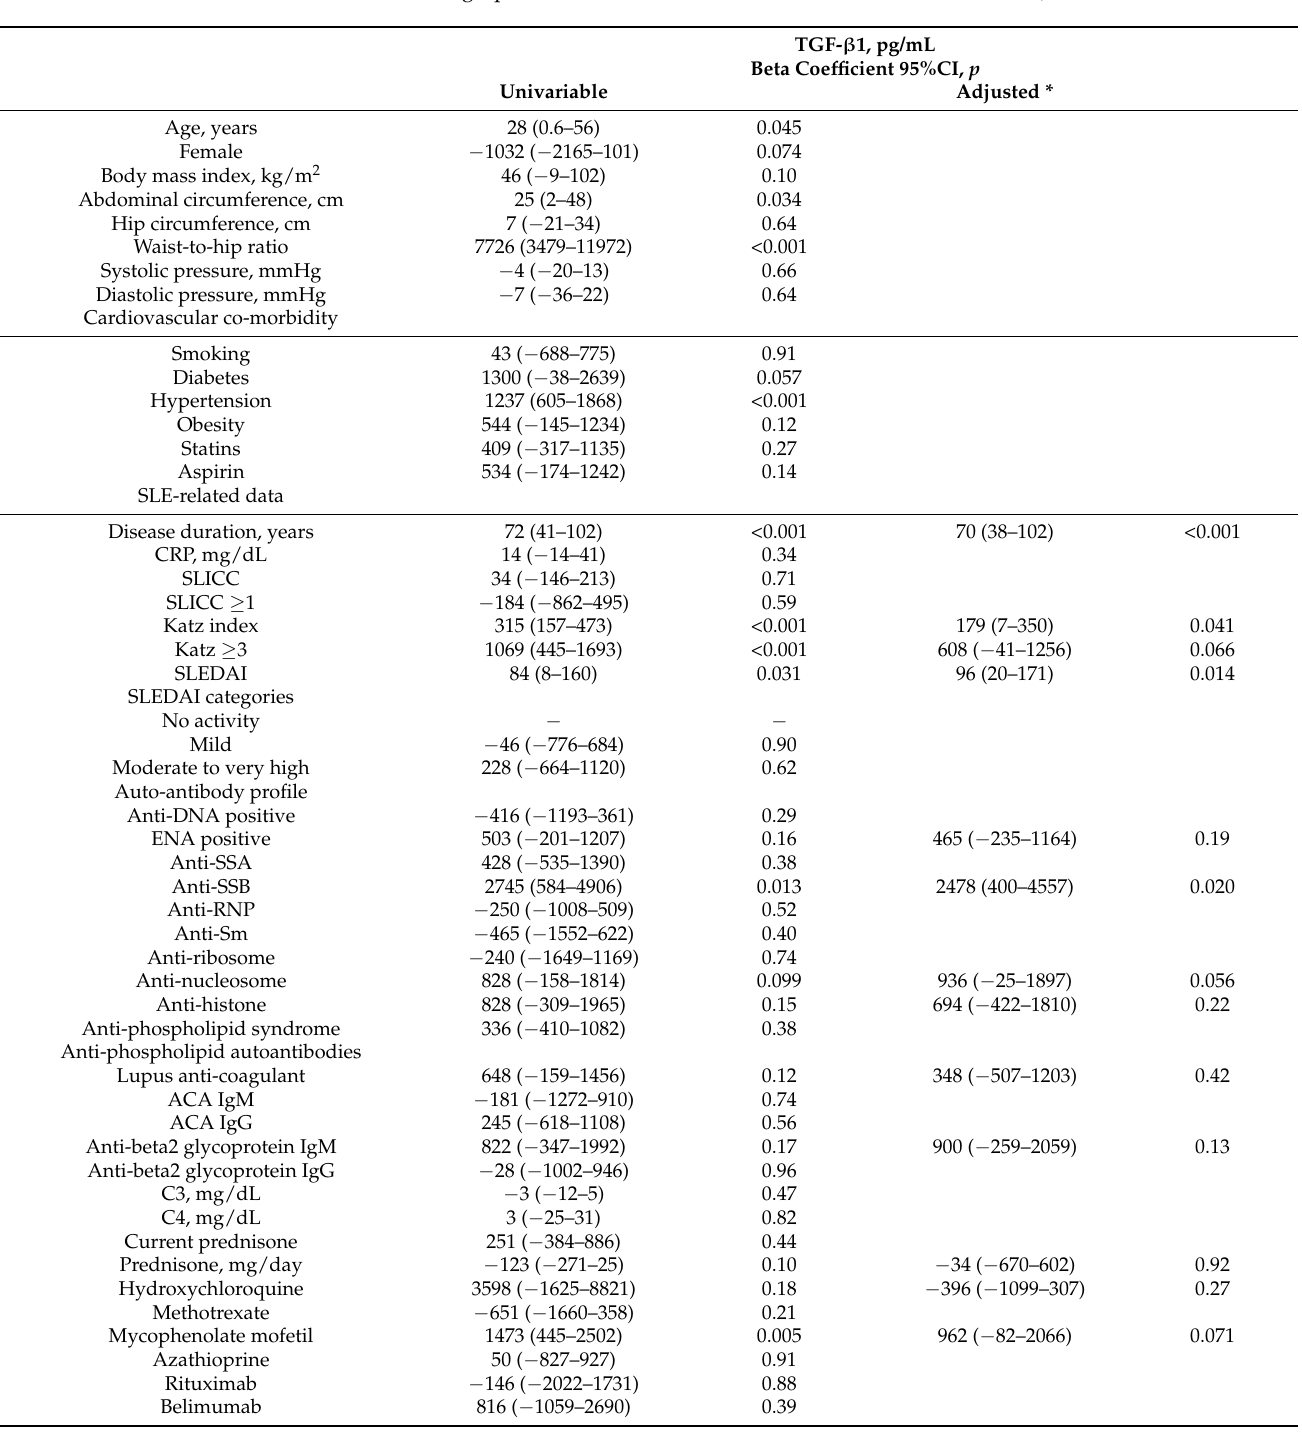
Table 2. Demographics and disease characteristics in relation to the TGF- β 1 serum